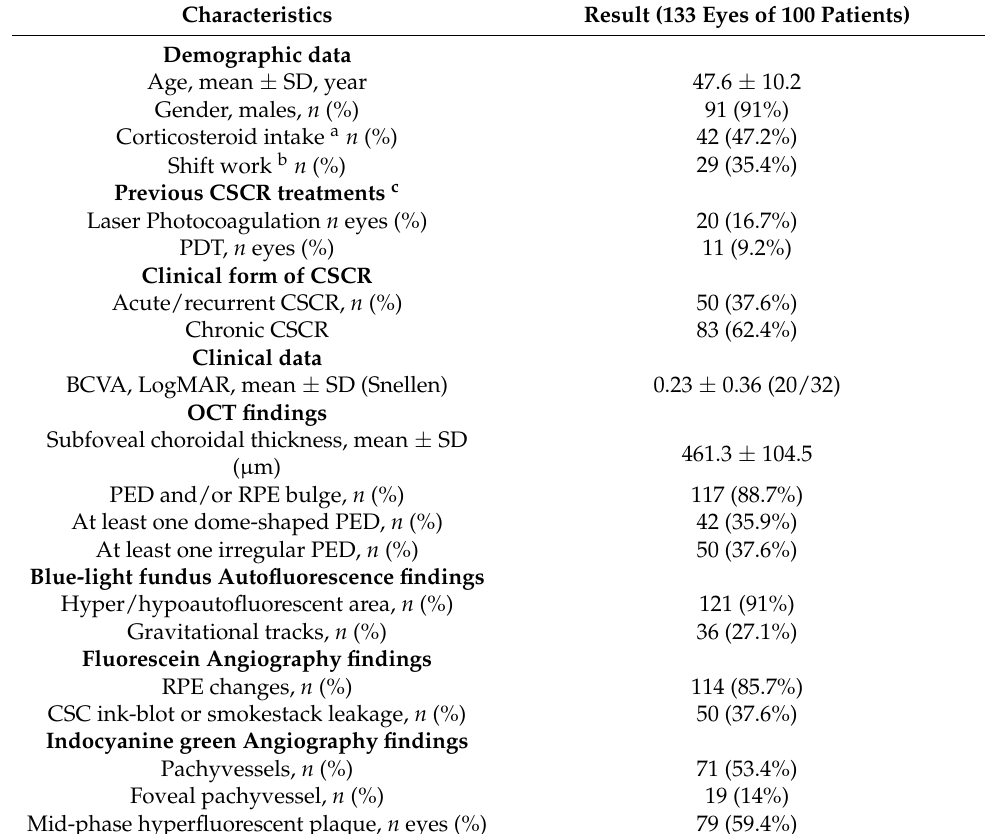
Table 1. Demographics, clinical and imaging data of eyes with central serous chorioretinopathy (CSCR) included in the